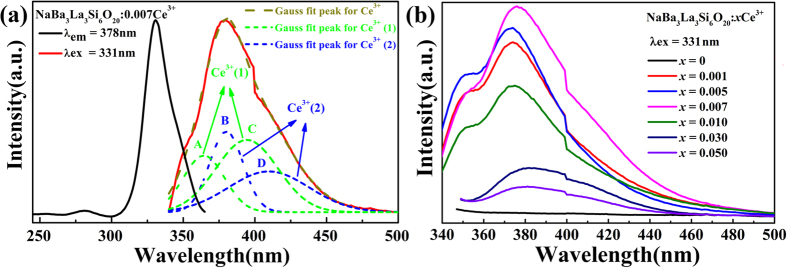
(a) The PLE (dark solid line) and PL spectra (red solid line) of the NaBa3La3Si6O20:0.007Ce3+ sample and the Gaussian peaks fitting (the green dashed lines of the Ce3+ (1) and the blue dashed lines of the Ce3+ (2)). (b) The PL spectra of the NaBa3La3Si6O20:xCe3+ samples with varying concentration of the Ce3+ ions.